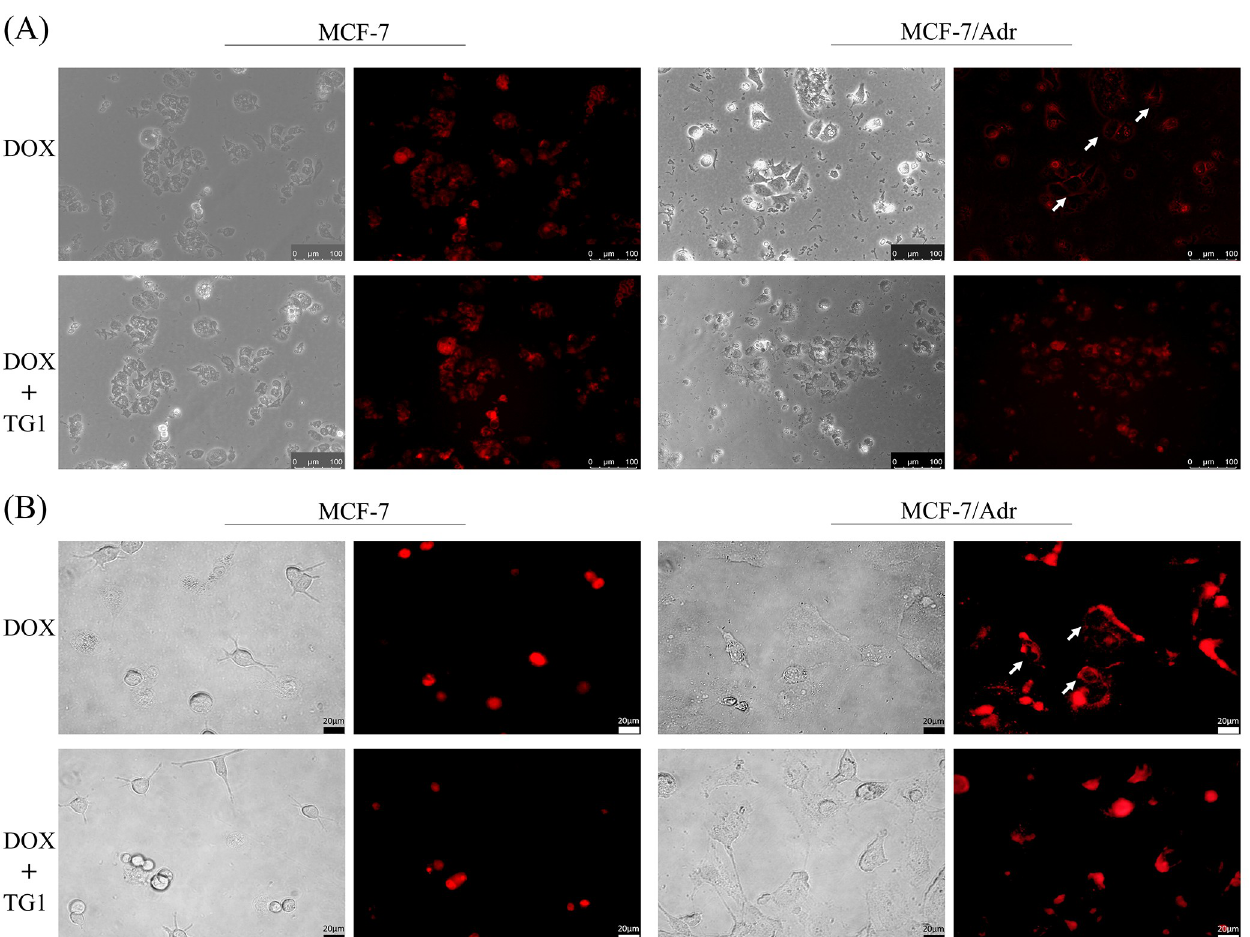
Fig 7. Fluorescence images of cellular uptake of DOX or DOX combined with TG1 in MCF-7 and MCF-7/Adr by inverted fluorescence microscope. (A) 20x images (B) 40x images.